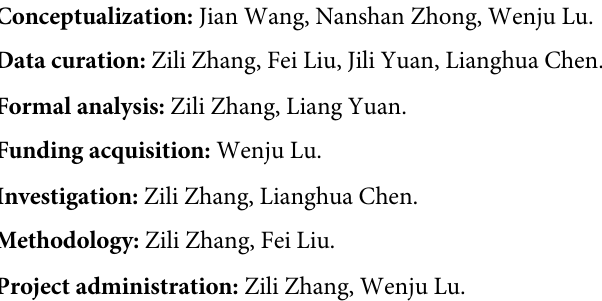
S5 Table. Spearman correlation coefficients for air pollutants, ambient temperature, and relative humidity, measured on a 24-hour